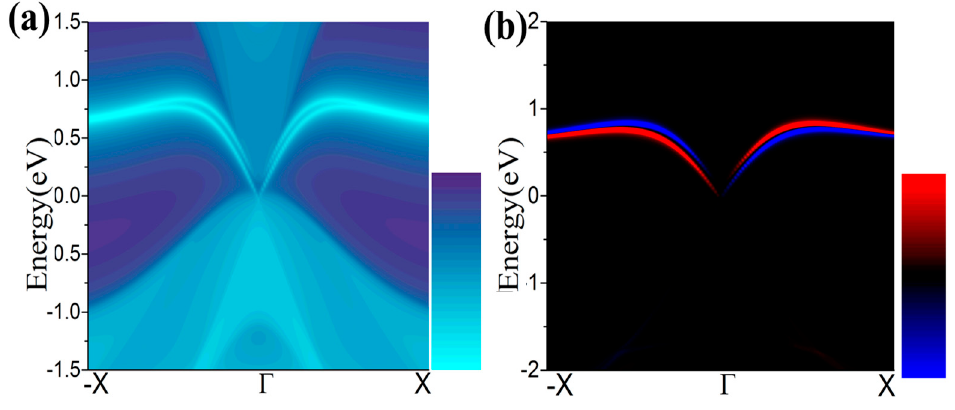
Figure 7. ( a , b ) The calculated Dirac edge states, and edge spin polarization, respectively.